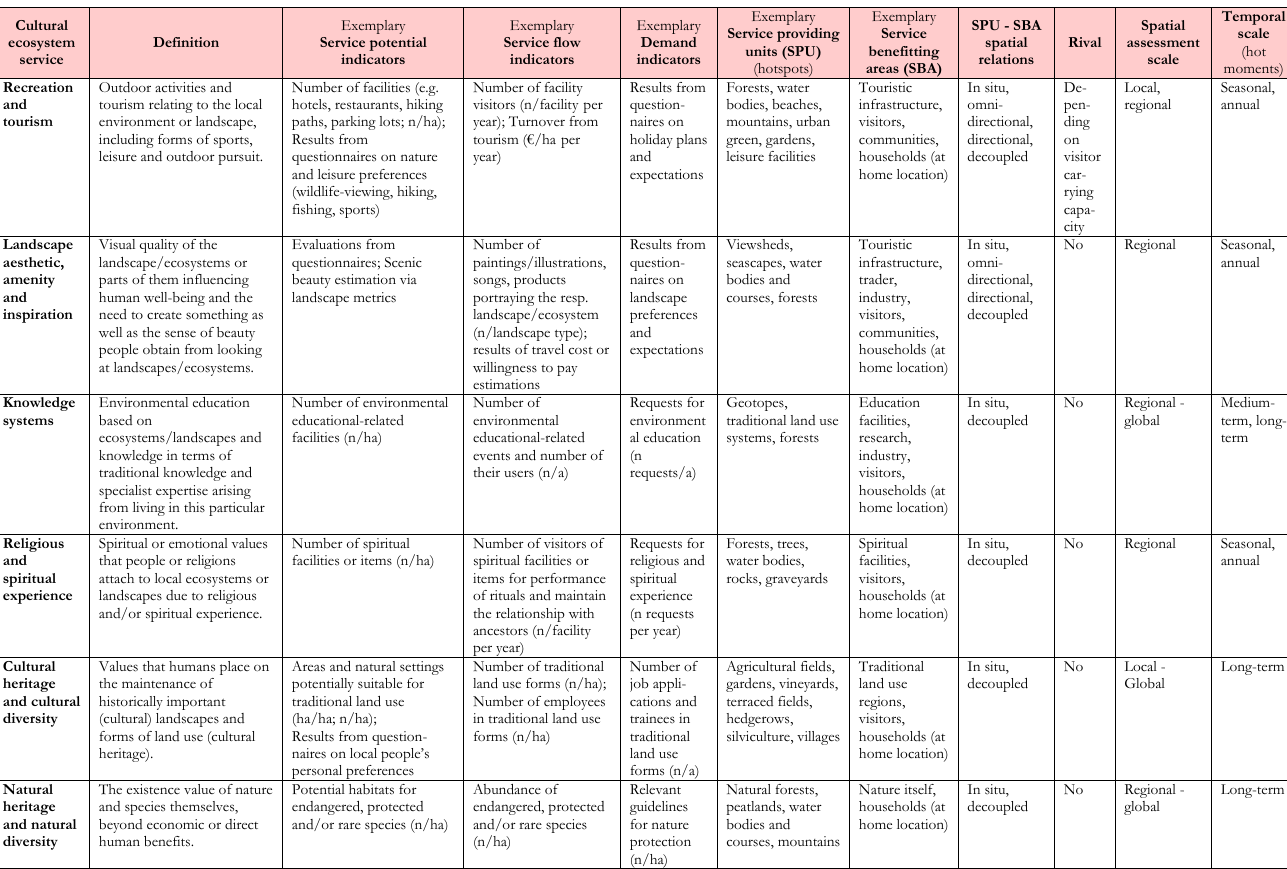
Table 3: Cultural ecosystem services: definitions, service potential (stock) indicators, service flow indicators, demand indicators, exemplary service providing units (hotspots) and service benefitting areas, suggested spatial and temporal assessment scales (based on Kandziora et al. 2013a; Burkhard et al. 2009 and 2012; Schröter et al. 2014; Syrbe and Walz 2012; de Groot et al.